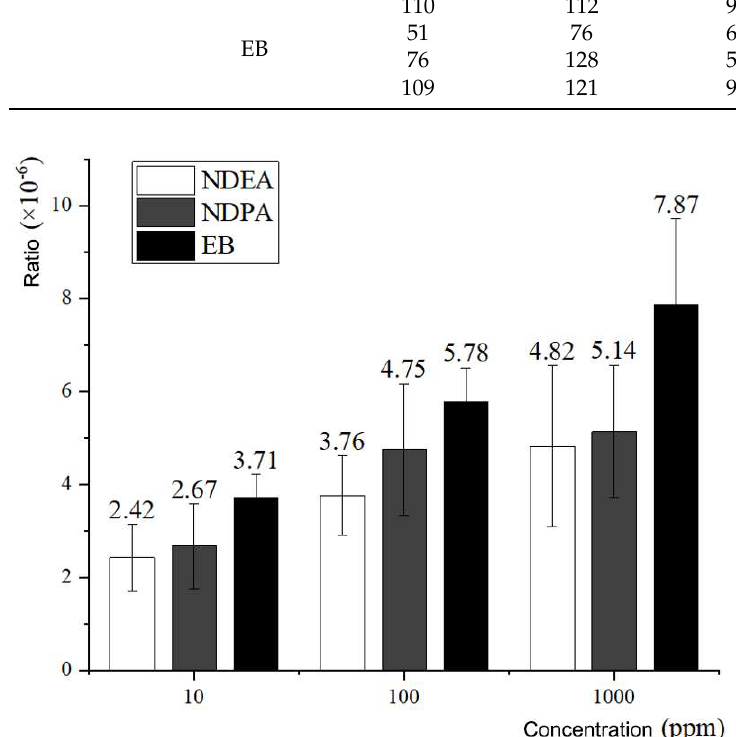
Figure 4. Comparison of rpsL mutation rates induced by NDEA, NDPA and EB.